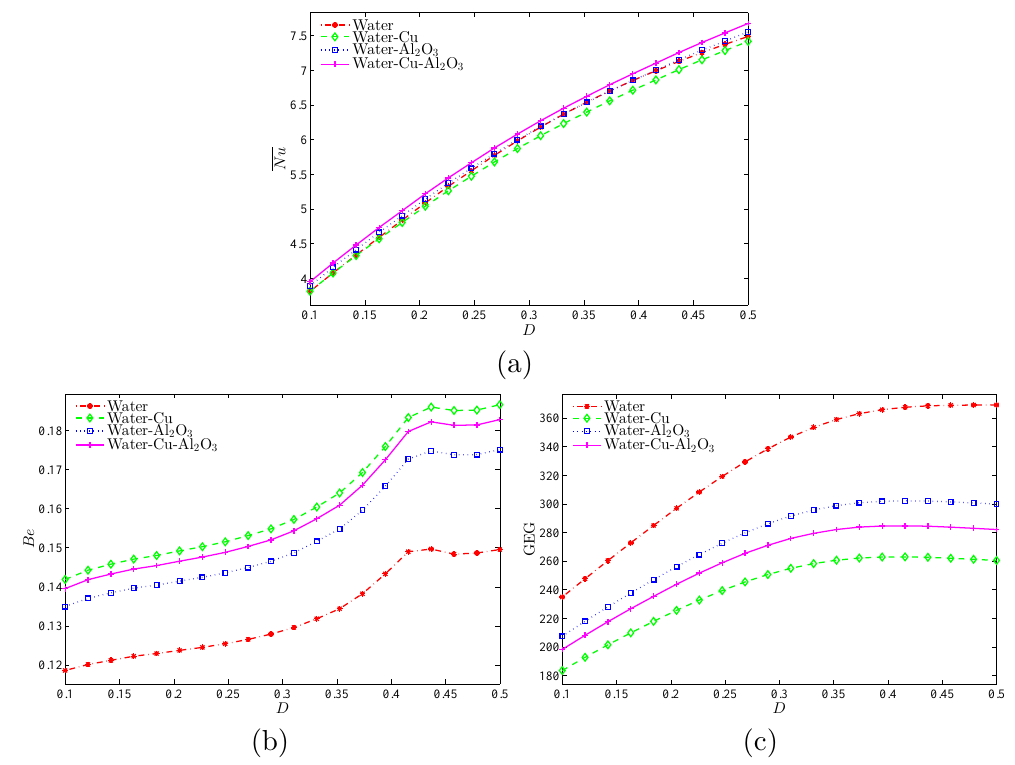
Figure 10. The evolution of the average characteristic as a function of D for nanofluids and hybrid nanofluids, ( a ) average Nusselt number ( Nu ), ( b ) Bejan number ( Be ), and ( c ) the global entropy generation (GEG) when Ra = 10 5 and φ =